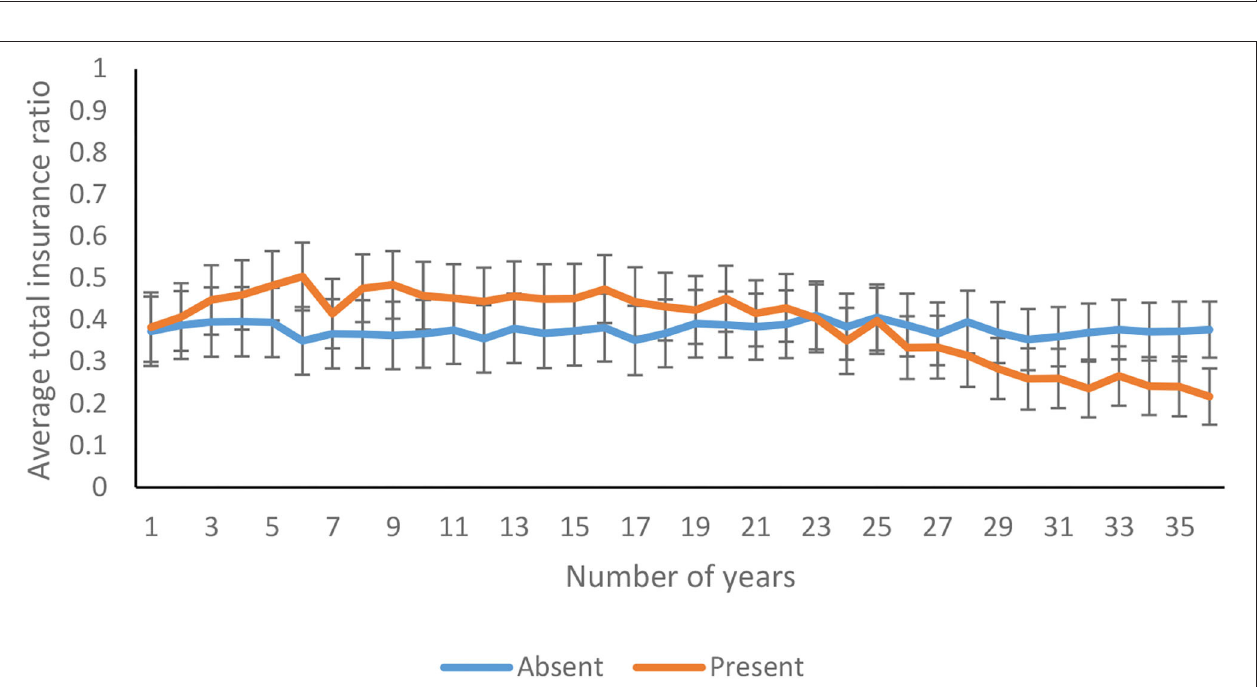
FIGURE 9 | Average mitigation ratio over years in feedback-present and absent conditions. The error bars show 95% CI around the point estimate.